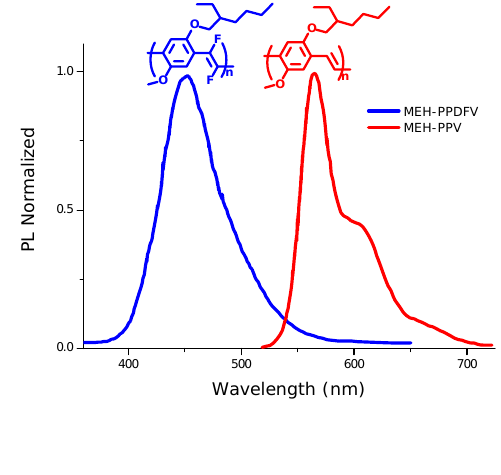
Figure 5. PL spectra of thin films of MEH-PPV and MEH-PPDFV